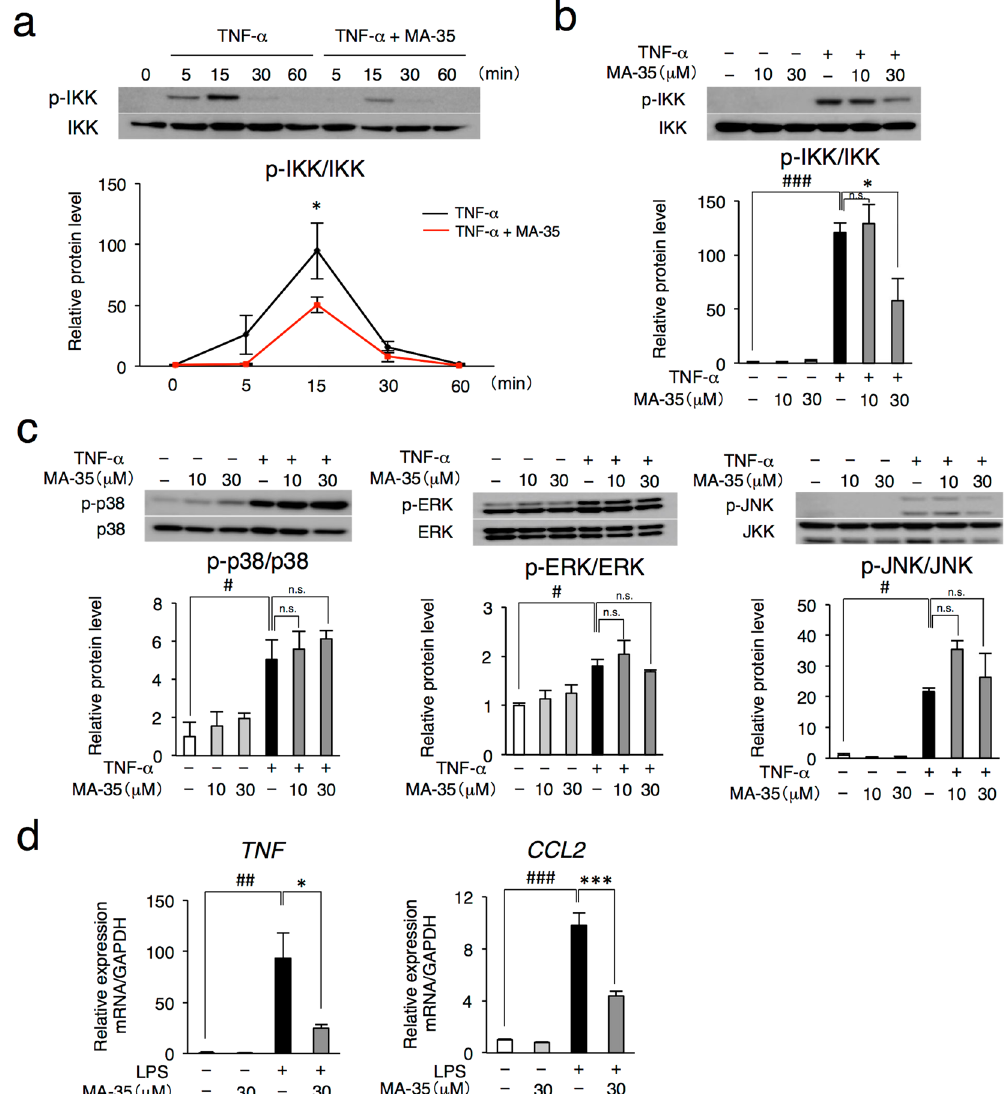
Figure 2. Effect of MA-35 on TNF- α -induced IKK phosphorylation and LPS-induced inflammatory cytokine expression in LX-2 cells. ( a ) Serum-starved LX-2 cells were preincubated for 60 min with or without MA-35 (30 μ M) and then stimulated with TNF- α (10 ng/mL). Cell lysates were prepared at the indicated time points and analyzed by immunoblotting for p-IKK and IKK protein. The expression levels of p-IKK was quantified by densitometry and normalized with IKK. Full-length gel was shown in Supplementary Fig. 2. Serum-starved LX-2 cells were preincubated for 60 min with or without MA-35 (10 μ M, 30 μ M) and then stimulated with TNF- α (10 ng/mL). For ( b ) 15 min and ( c ) 30 min. The expression levels of ( b ) p-IKK, ( c ) p-p38, p-ERK and p-JNK were quantified by densitometry, and each was normalized with IKK, p38, ERK and JNK, respectively. Full-length gel was shown in Supplementary Fig. 4. Serum-starved LX-2 cells were preincubated for 60 min with or without MA-35 (30 μ M) and then stimulated with LPS (100 ng/mL). ( d ) The mRNA level of TNF after 1 h LPS stimulation and CCL2 after 3 h LPS stimulation were measured by real-time PCR. # p < 0.05, ## p < 0.01, ### p < 0.001 v.s. Control, * p < 0.05, *** p < 0.001 v.s. TNF- α or